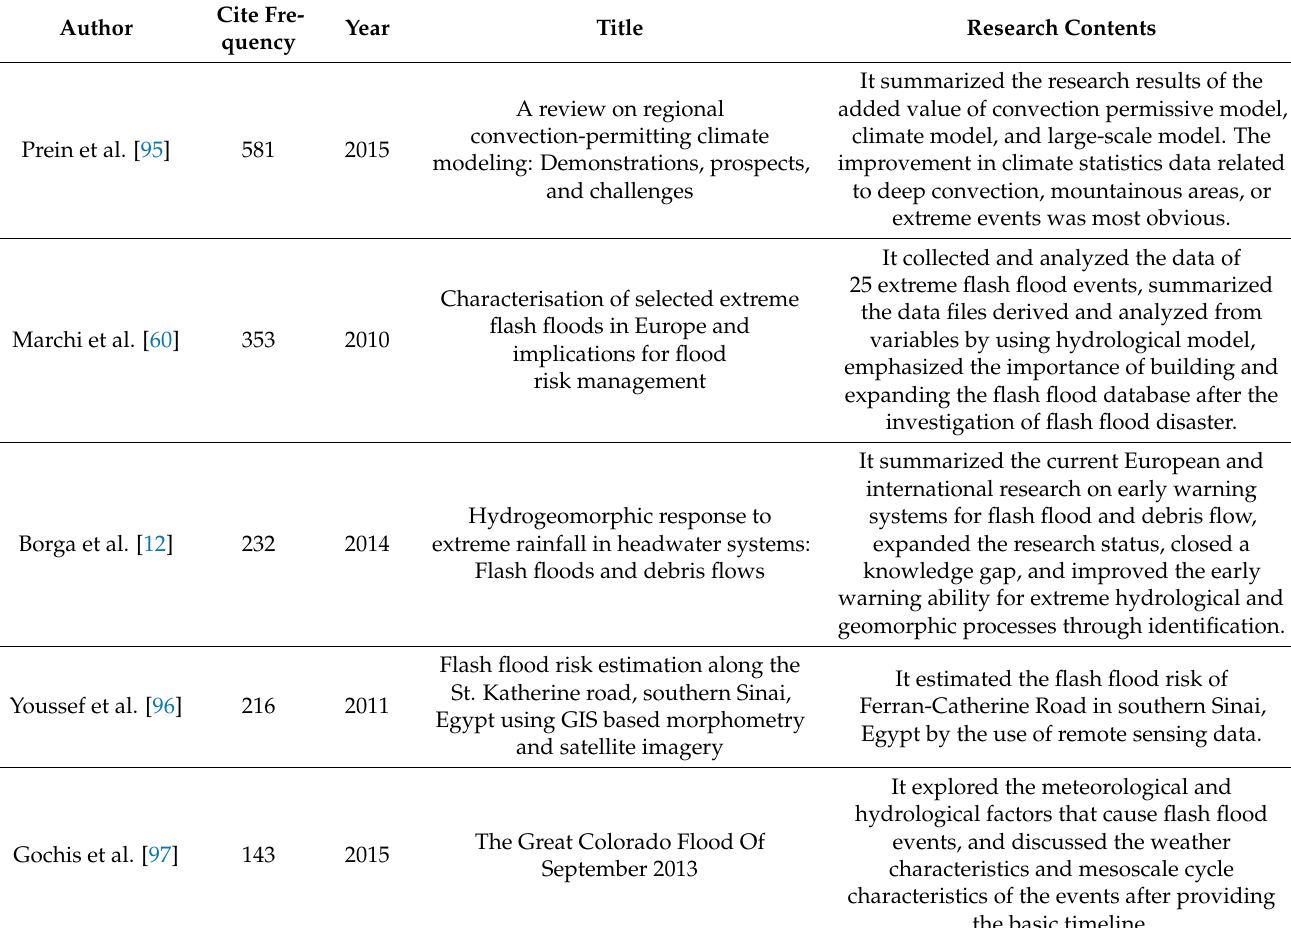
Table 3. Analysis of highly cited papers (top 5).